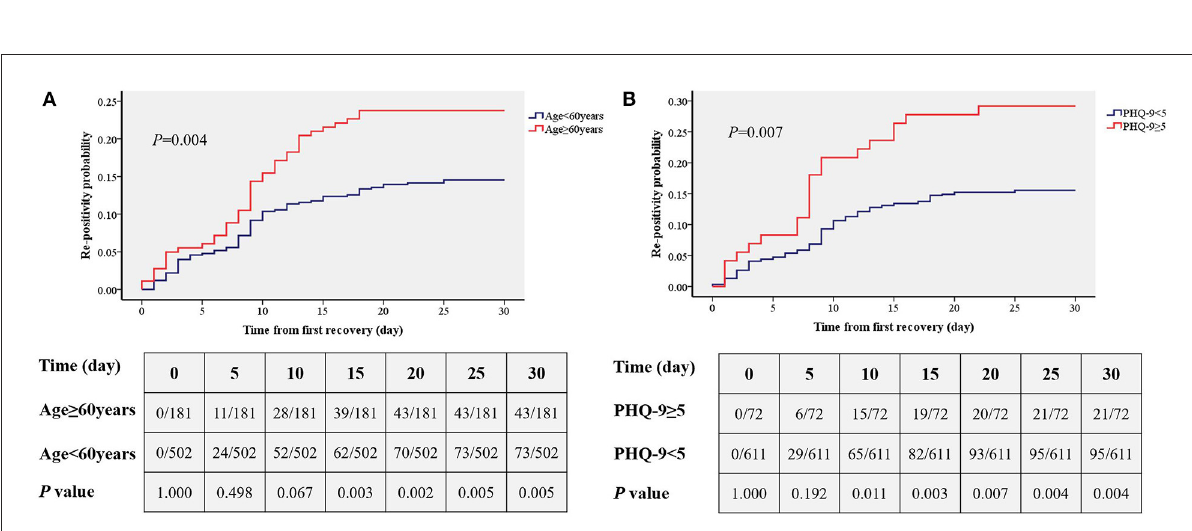
FIGURE3 Comparisons of the accumulated rates of re-positivity between different age group (A) and depression status (B) . PHQ-9, patient health questionnaire